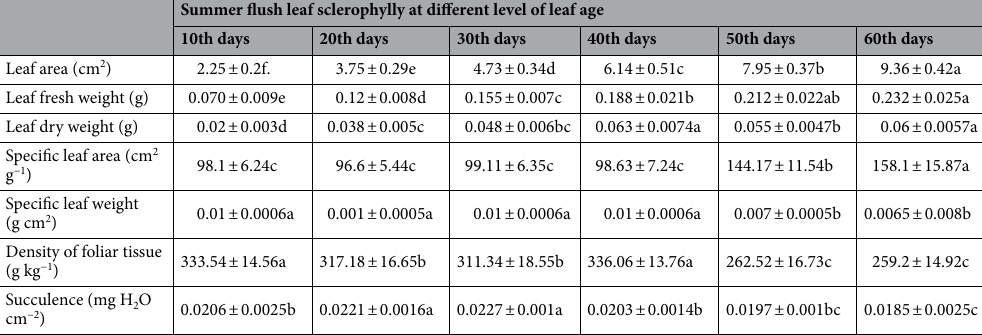
Summer flush leaf sclerophylly at different level of leaf